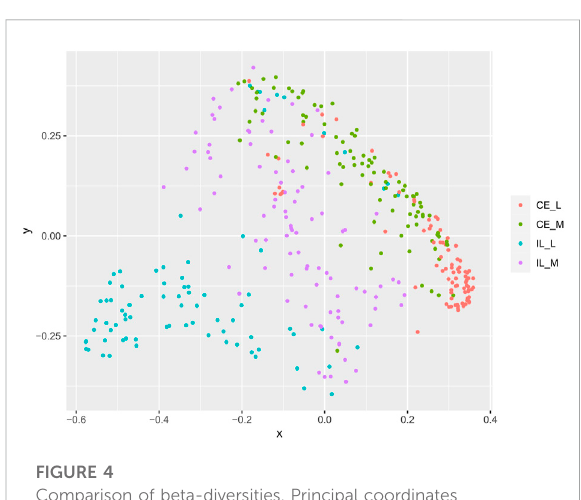
FIGURE 4 Comparison of beta-diversities. Principal coordinates analysis of Bray-Curtis matrices at each site. Community structure at all sites differed from all other